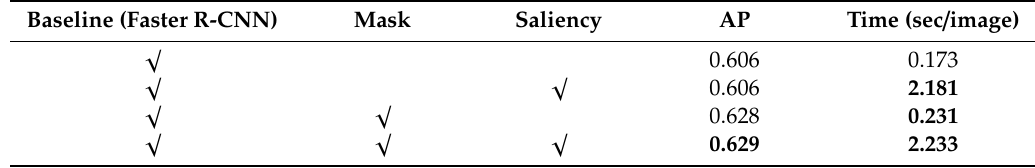
Table 5. The comparison of time consumption.